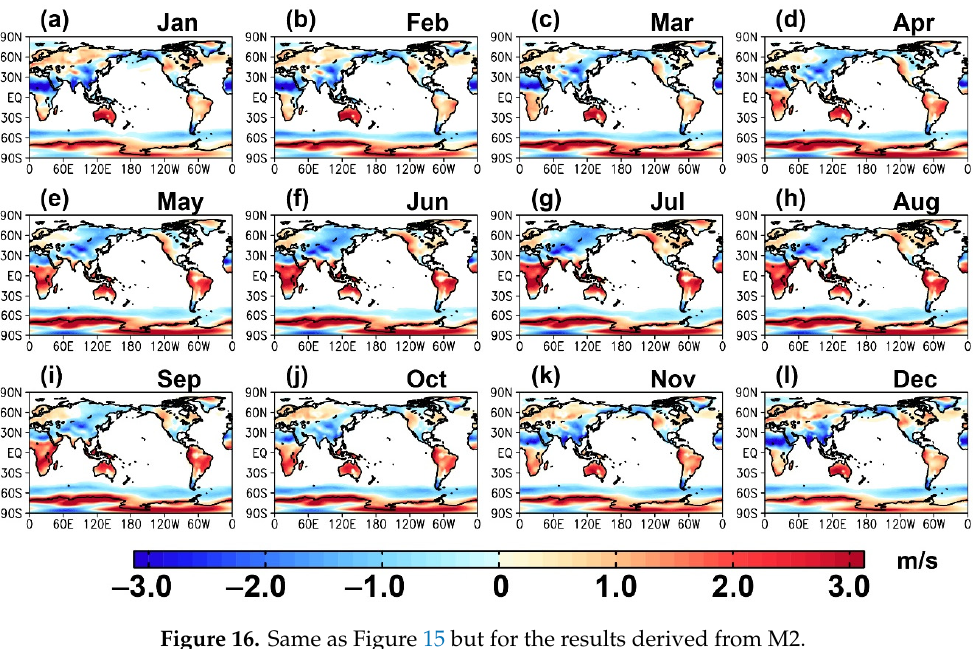
Figure 16. Same as Figure 15 but for the results derived from M2. Atmosphere 2020 , 11 , x FOR PEER REVIEW